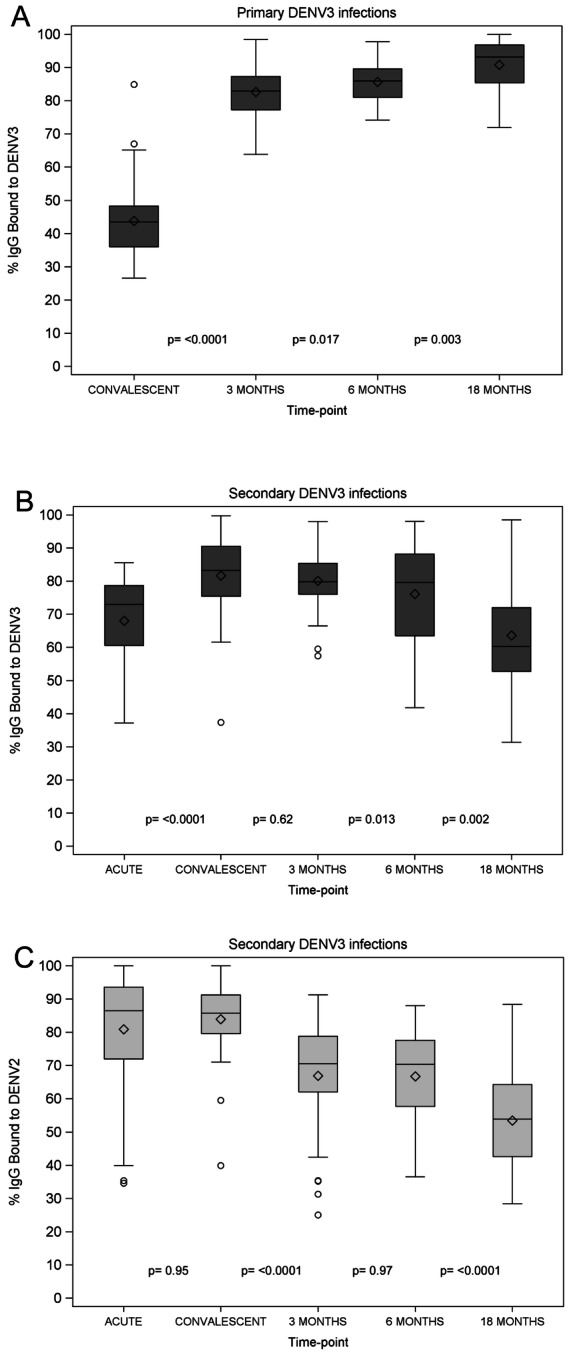
Longitudinal analysis of DENV-specific serum IgG and IgM avidity.
A. IgG serum avidity to DENV3 day 14–28 (convalescent), 3 m, 6 m and 18 m post-onset of symptoms in 1° DENV3 infections. Longitudinal serum samples were tested for DENV-specific avidity using a modified ELISA with 6M urea washes against DENV3 strain N7236 virions. The mean +/− SD as well as the 25th and 75th percentiles of % IgG bound are displayed. B. IgG serum avidity to DENV3 day 6 (acute), day 14–28 (convalescent), 3 m, 6 m and 18 m post-onset of symptoms in 2° DENV3 infections. Longitudinal serum samples were analyzed as in Figure 2A. C. DENV3-specific IgG serum avidity day 6 (acute), day 14–28 (convalescent), 3 m, 6 m and 18 m post-onset of symptoms in 2° DENV3 infections. Longitudinal serum samples were analyzed as in Figure 2A. Diamonds, mean; middle line, median; upper and lower boundary of the box, intra-quartile range (IQR; 25th to 75th percentile); whiskers, range of values that are outside of the IQR but are close enough not to be considered outliers (≤1.5*IQR); empty circles, outliers >1.5*IQR.